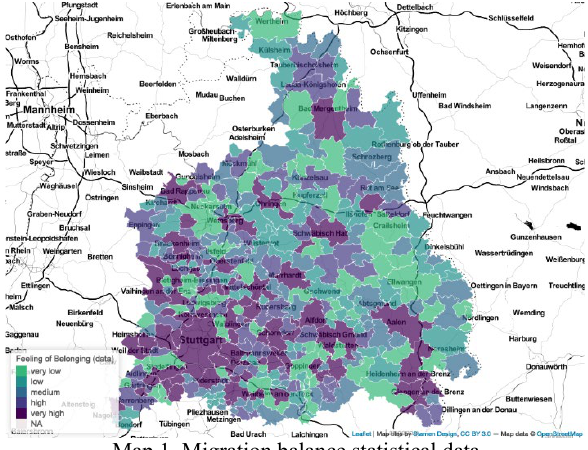
Map 1. Migration balance statistical